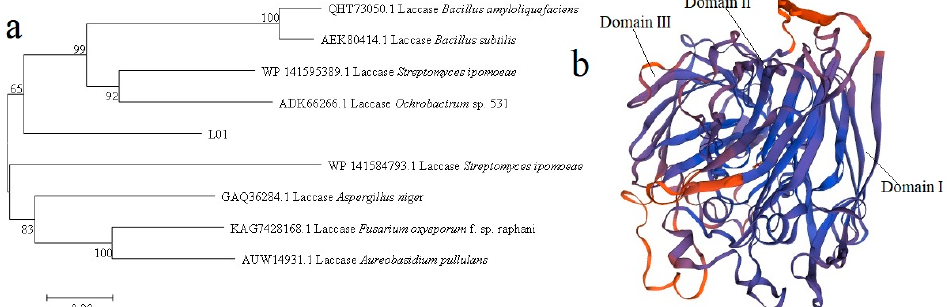
Figure 1. ( a ) Phylogenetic tree constructed by the neighbor-joining method with amino acid sequences of L01 and reported laccases. ( b ) Structure model of L01 by SWISS-MODEL based on the amino sequence.